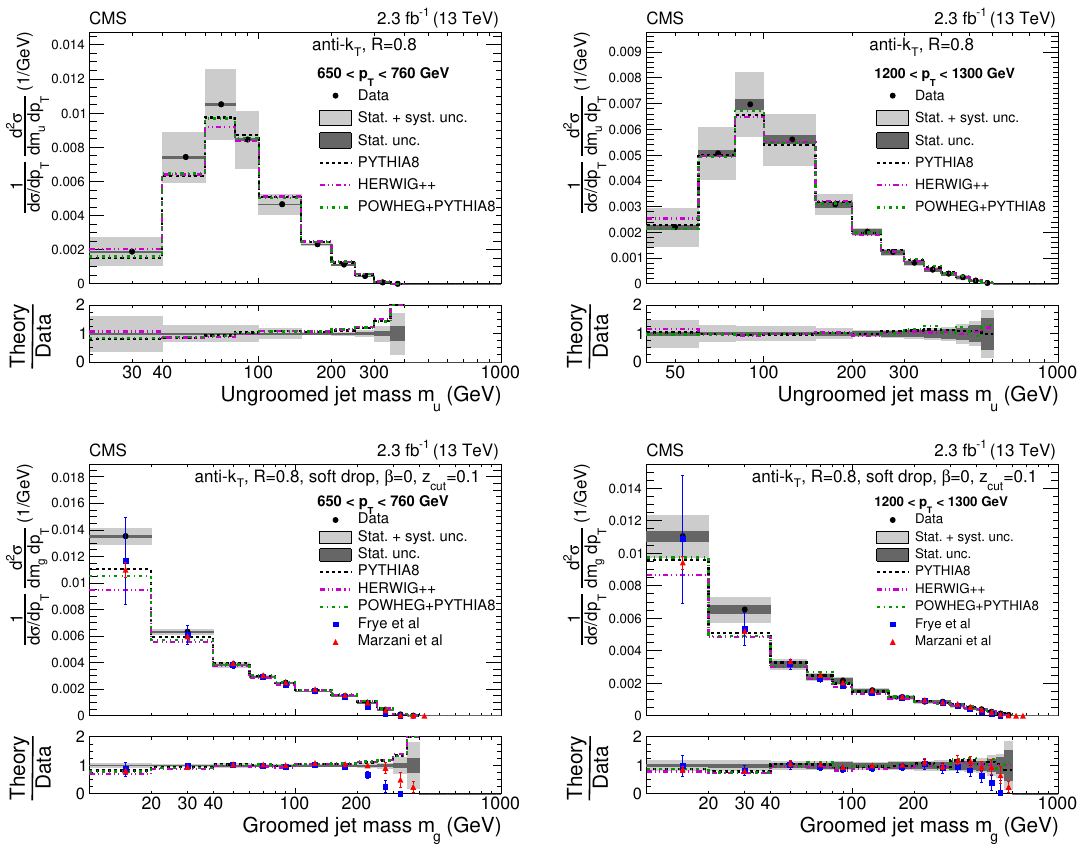
Figure 7 . Normalized cross section for the ungroomed (top) and groomed (bottom) jets for two p T bins. The predictions from pythia 8, herwig++ , and powheg + pythia are shown with dashed black, dash-dot-dotted magenta, and dash-dotted green histograms, respectively, with no uncertainties shown. The predictions from ref. [17] (Frye et al.) are shown with blue squares. The uncertainties include scale variations and an estimate of nonperturbative e(cid:11)ects. The predictions from ref. [18] (Marzani et al.) are shown with red triangles. The uncertainties include only ef- fects from scale variations, since nonperturbative corrections have been considered directly in the calculation. Both predictions diverge from the data at high mass due to (cid:12)xed-order